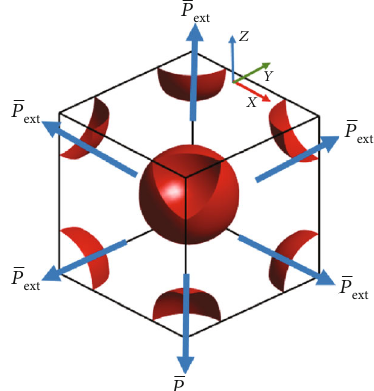
Figure 4: BCC unit cell under hydrostatic pressure schematic using (cid:1) = depicts stress in the f ii g direction isosurface construction; σ P ext ii components, shear stress components f i ≠ j g , are equal where all σ ij to zero.